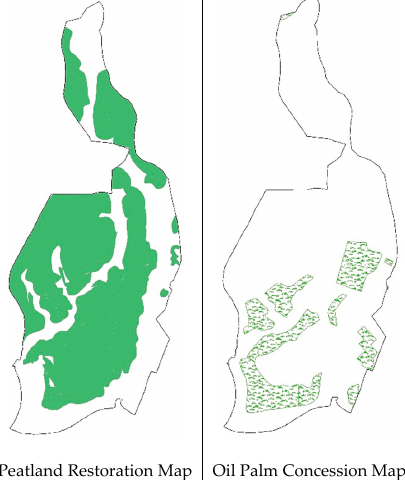
Figure A1. Land Suitability Maps used for the Scenarios. Table A3. BAU Transition Matrix.